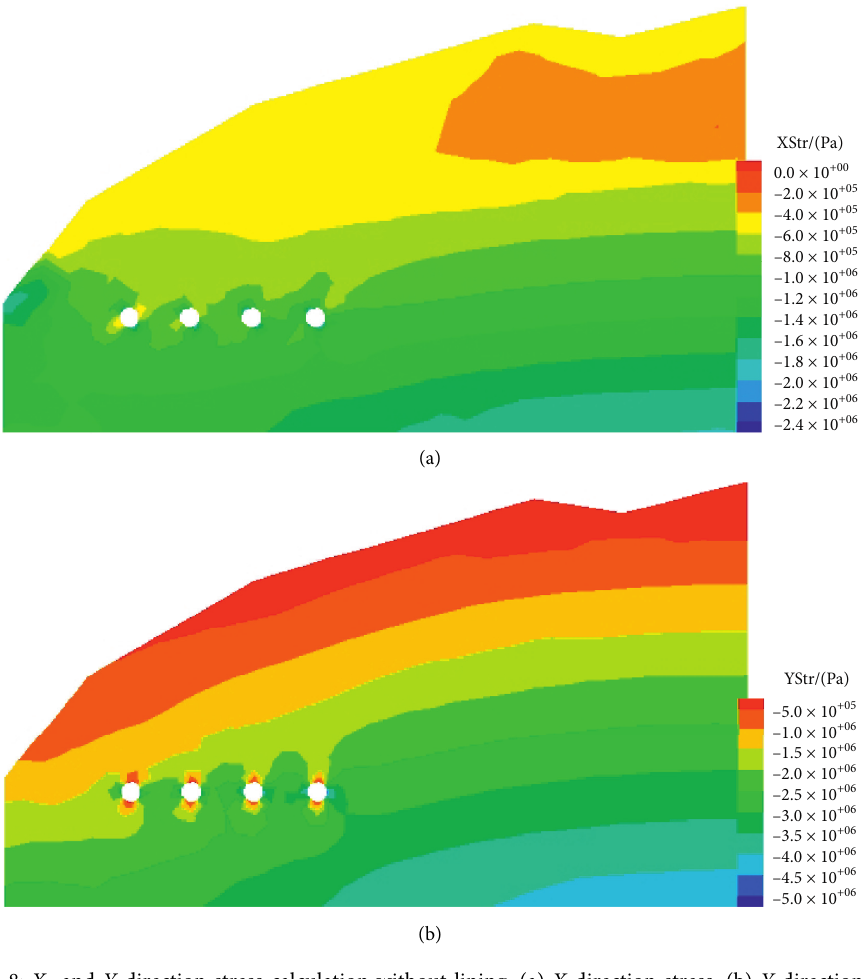
Figure 8: X - and Y -direction stress calculation without lining. (a) X -direction stress. (b) Y -direction